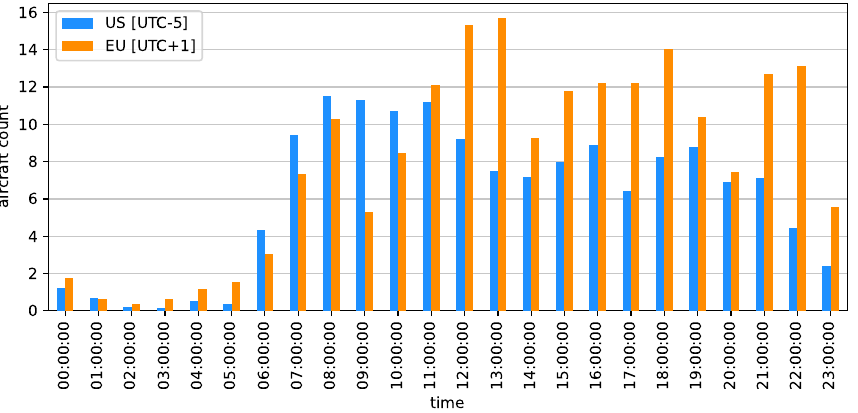
Figure 4. Temporal variation in average aircraft count for the two hot spots for each hour of the day, over all days in January 2022.